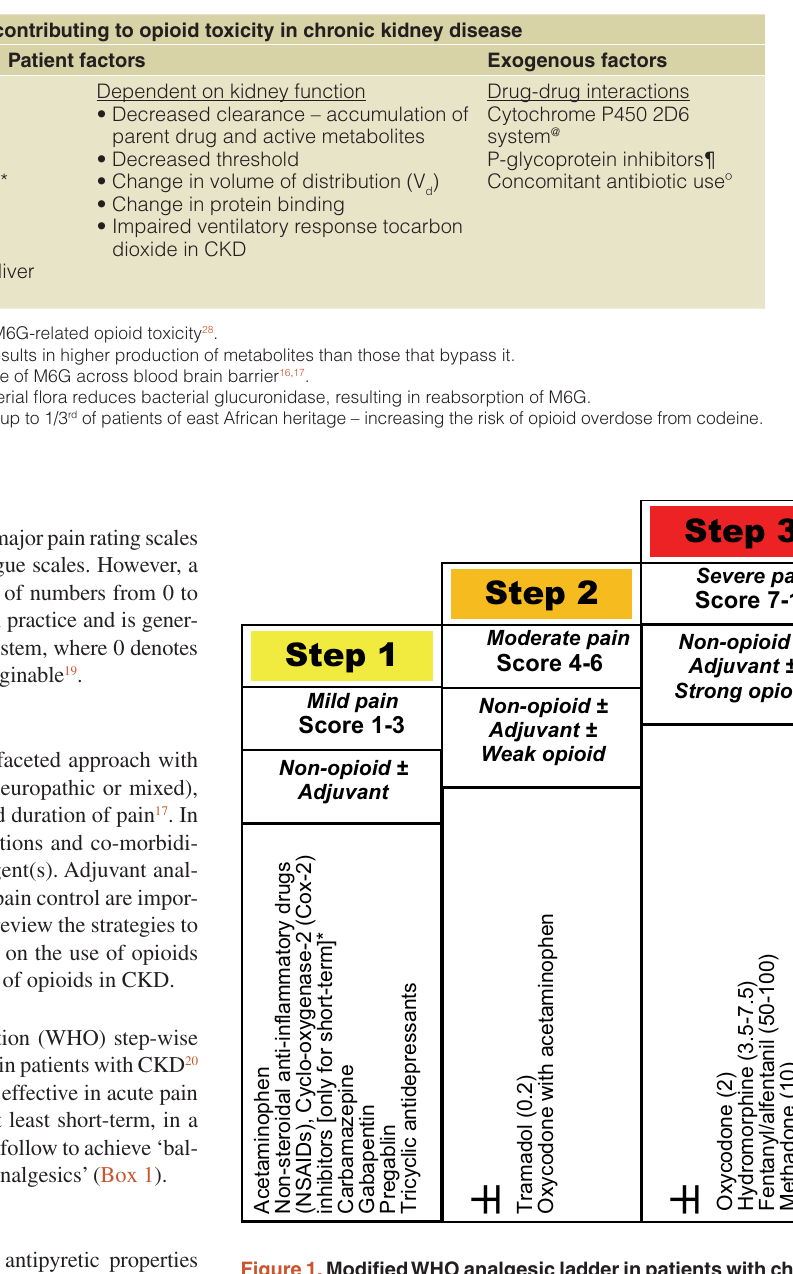
Figure 1. Modified WHO analgesic ladder in patients with chronic kidney disease [adapted from references 17,18 ], with relative potency compared to morphine (1) of commonly used opioids in parenthesis. *Non-steroidal anti-inflammatory agents, including cyclo-oxygenase-2 inhibitors should be avoided, except for acute pain with close clinical observation.